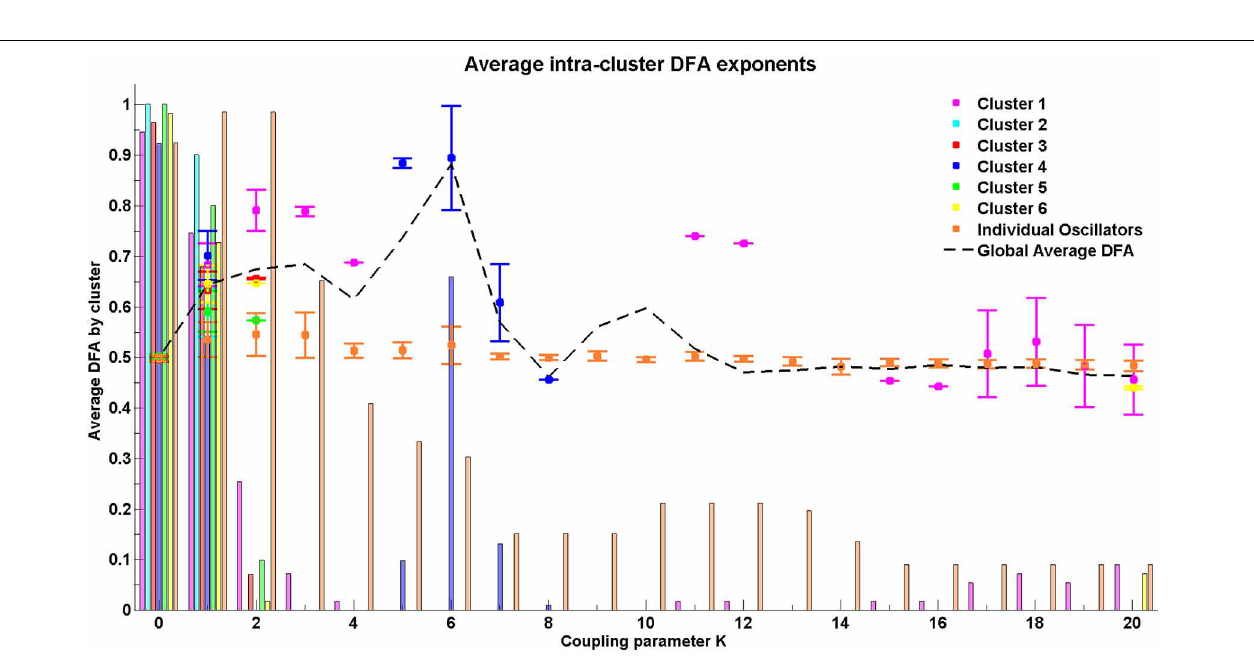
proportion of valid exponents, as calculated by ML-DFA, are indicated by bars. The Kuramoto model order parameter r is in blue, and the quantity (cid:11) ( Kr ) is in cyan. The peak (cid:11) ( Kr ) has been used as an indicator of the effective critical coupling. A horizontal line at DFA exponent 0.5 is plotted to guide the eye. The proportion of valid DFA bars for K = 0, K = 1, and K = 6 have been shaded in magenta.